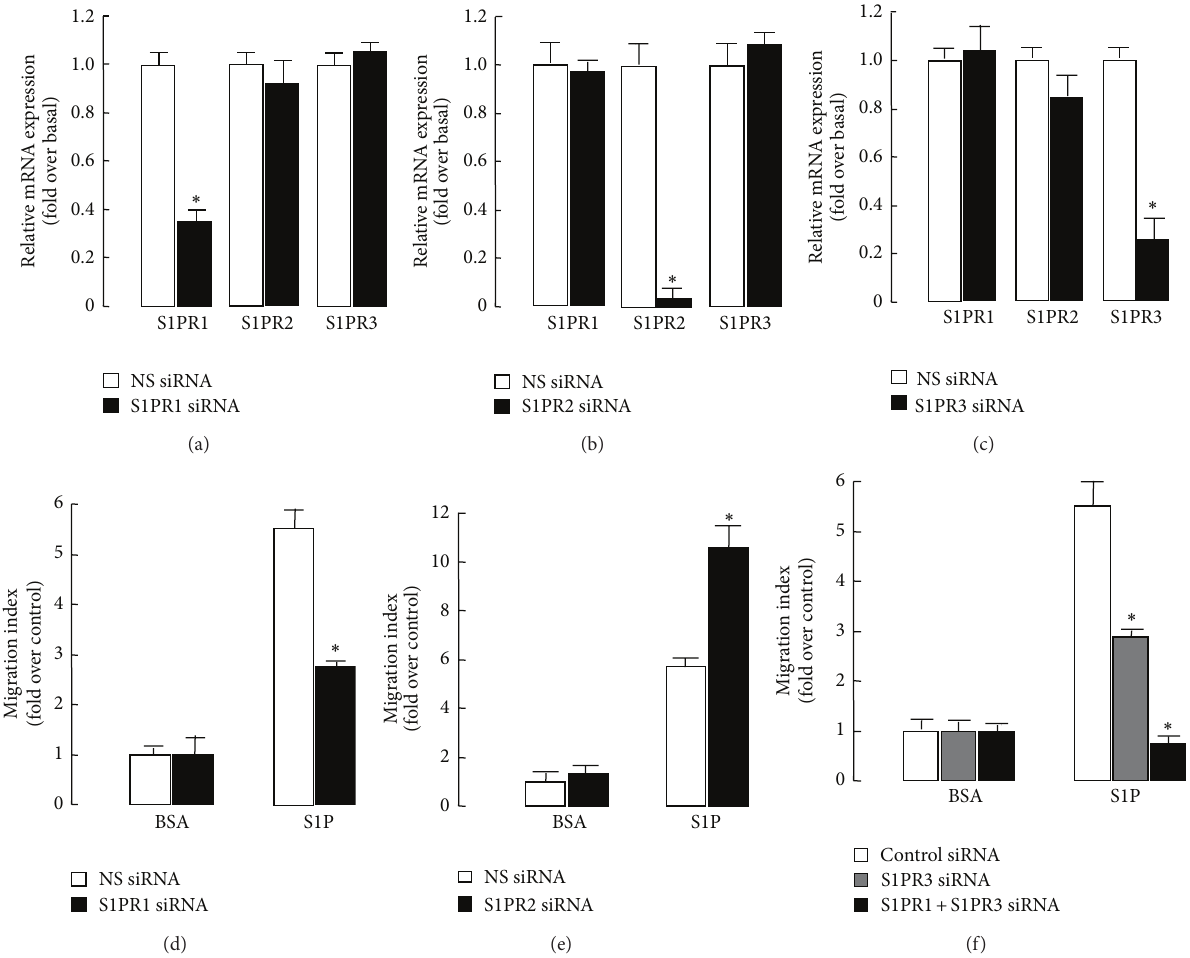
Figure 3: The effect of silencing S1PR expression on S1P-induced migration in human BMSCs. (a)–(c) Cells were transfected with control siRNA or with siRNA targeted against S1PR1 (a), S1PR2 (b), or S1PR3 (c) for 48 h. Then S1PR1, S1PR2, or S1PR3 mRNA was evaluated by real-time RT-PCR. (d)–(f) Effect of silencing S1PR1, S1PR2, or S1PR3 expression on human BMSCs migration in response to S1P. Data are presented as the mean ± SD. ∗ 𝑃 < 0.05 , compared with control